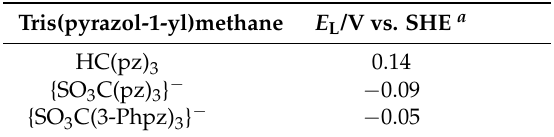
Table 2. Electrochemical E L Lever ligand parameter for C-homoscorpionate